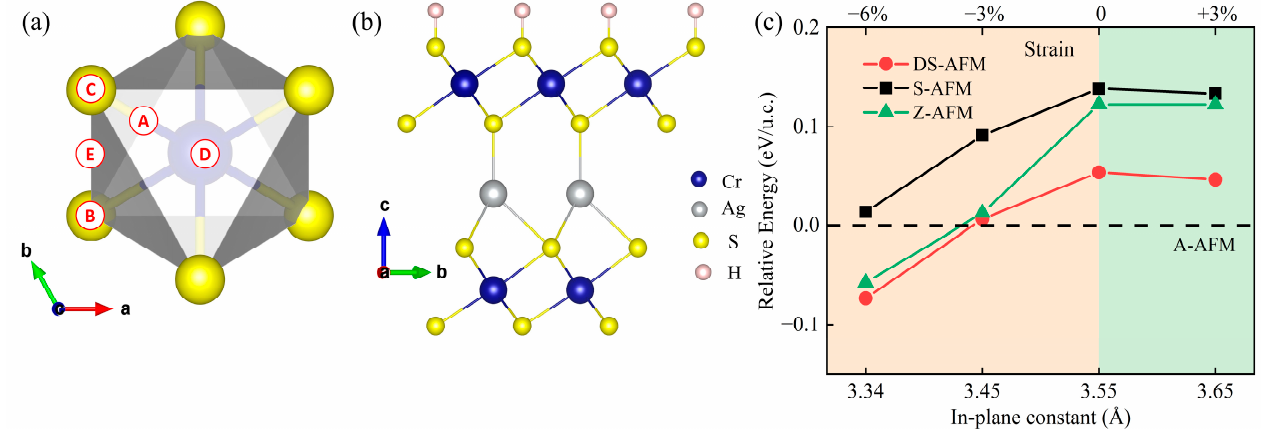
Figure 3. The density of states (DOS) of bulk AgCrS 2 ( upper panel ) and monolayer AgCr 2 S 4 ( lower panel ).